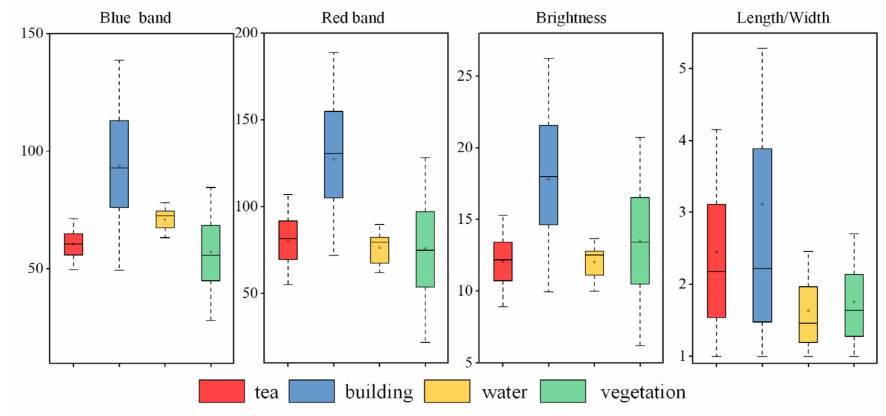
Figure 9. The difference among classes in digital imagery